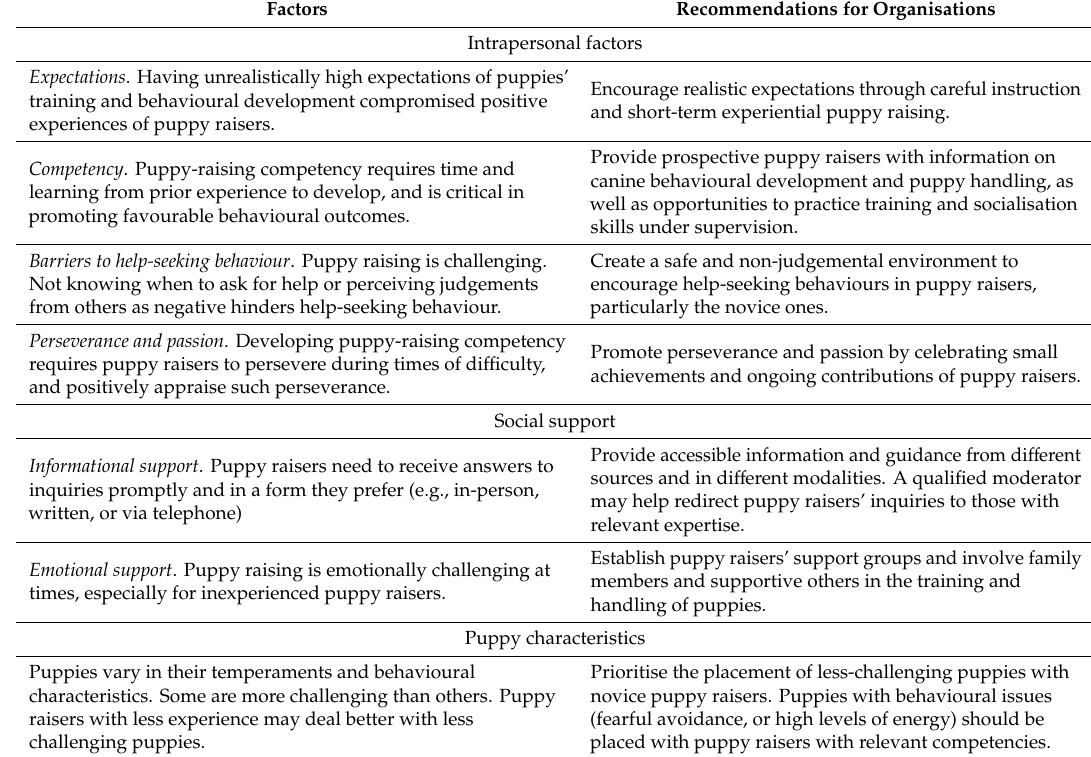
Figure 2. Proposed interrelations between various factors affecting puppy-raising practices. Table 2. Summary of factors a ff ecting puppy raising and recommendations for